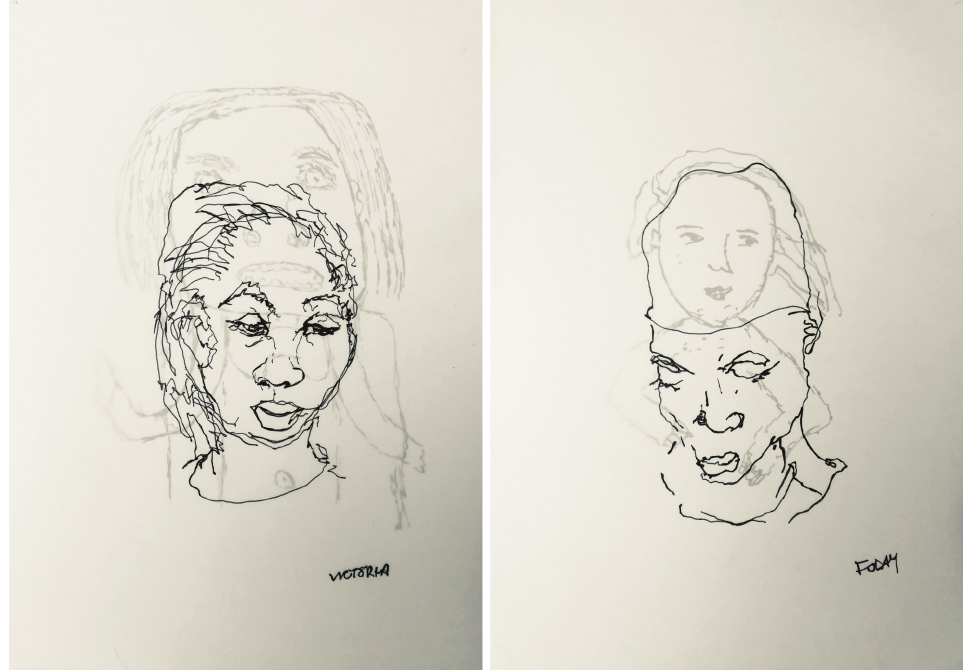
Figure 1. Victoria, Interfacings Series, 2006. Leslie Iwai, Artist ( left ), Foday, Interfacings Series, 2006 Leslie Iwai, Artist ( right